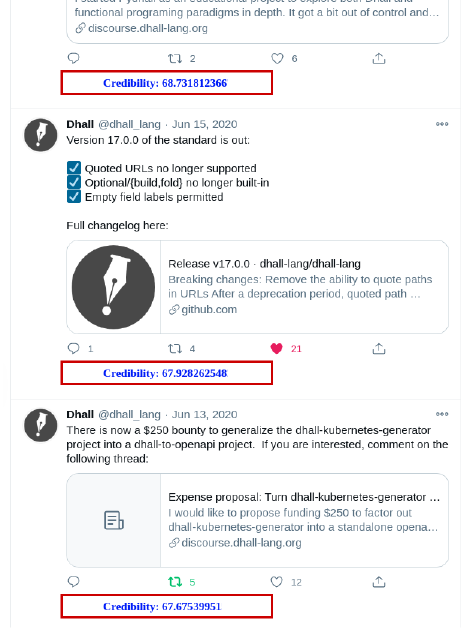
Figure 10. Credibility values under an account’s timeline.